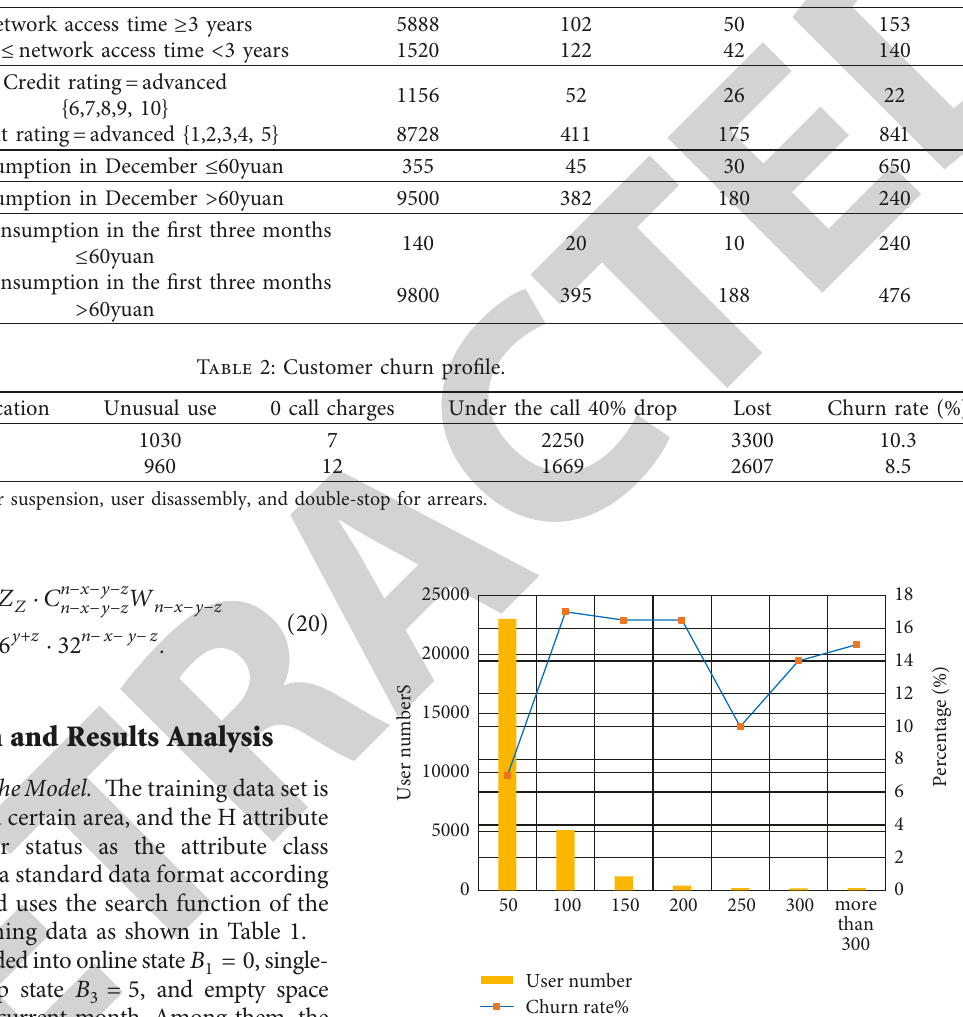
Figure 9: Churn vs Average Revenue Per